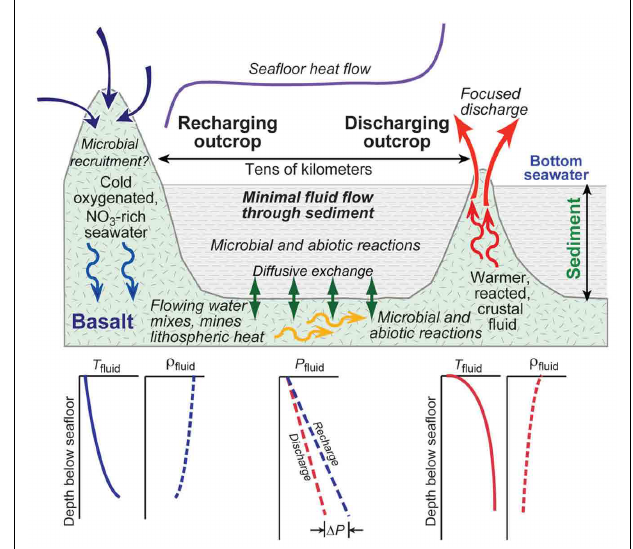
FIGURE 1 | Schematic illustrations of the causes and impacts of ridge flank hydrothermal circulation. In this example, seamounts or other basement outcrops play a key role in guiding fluid flow into and out of the crust, between areas that are blanketed with marine sediment.Within recharging and discharging volcanic rock outcrops, fluid temperatures ( T fluid ) and densities ( r fluid ) remain relatively constant so long as vertical transport (descent and ascent) is rapid.The difference between fluid pressures ( P fluid ) at the base of recharging and discharging columns of fluid (C). Δ P , is the primary driving force for ridge flank hydrothermal circulation.This pressure difference is available to move fluid laterally within the reactive basement aquifer, mining heat, reacting with the crust, and providing nutrients and/or energy to microbial communities living in pore spaces. Seafloor heat flow is generally higher adjacent to discharging outcrops, and lower adjacent to recharging outcrops. Between outcrops, heat flow may be equal to or less than conductive plate cooling values, depending on the regional efficiency of lithospheric heat